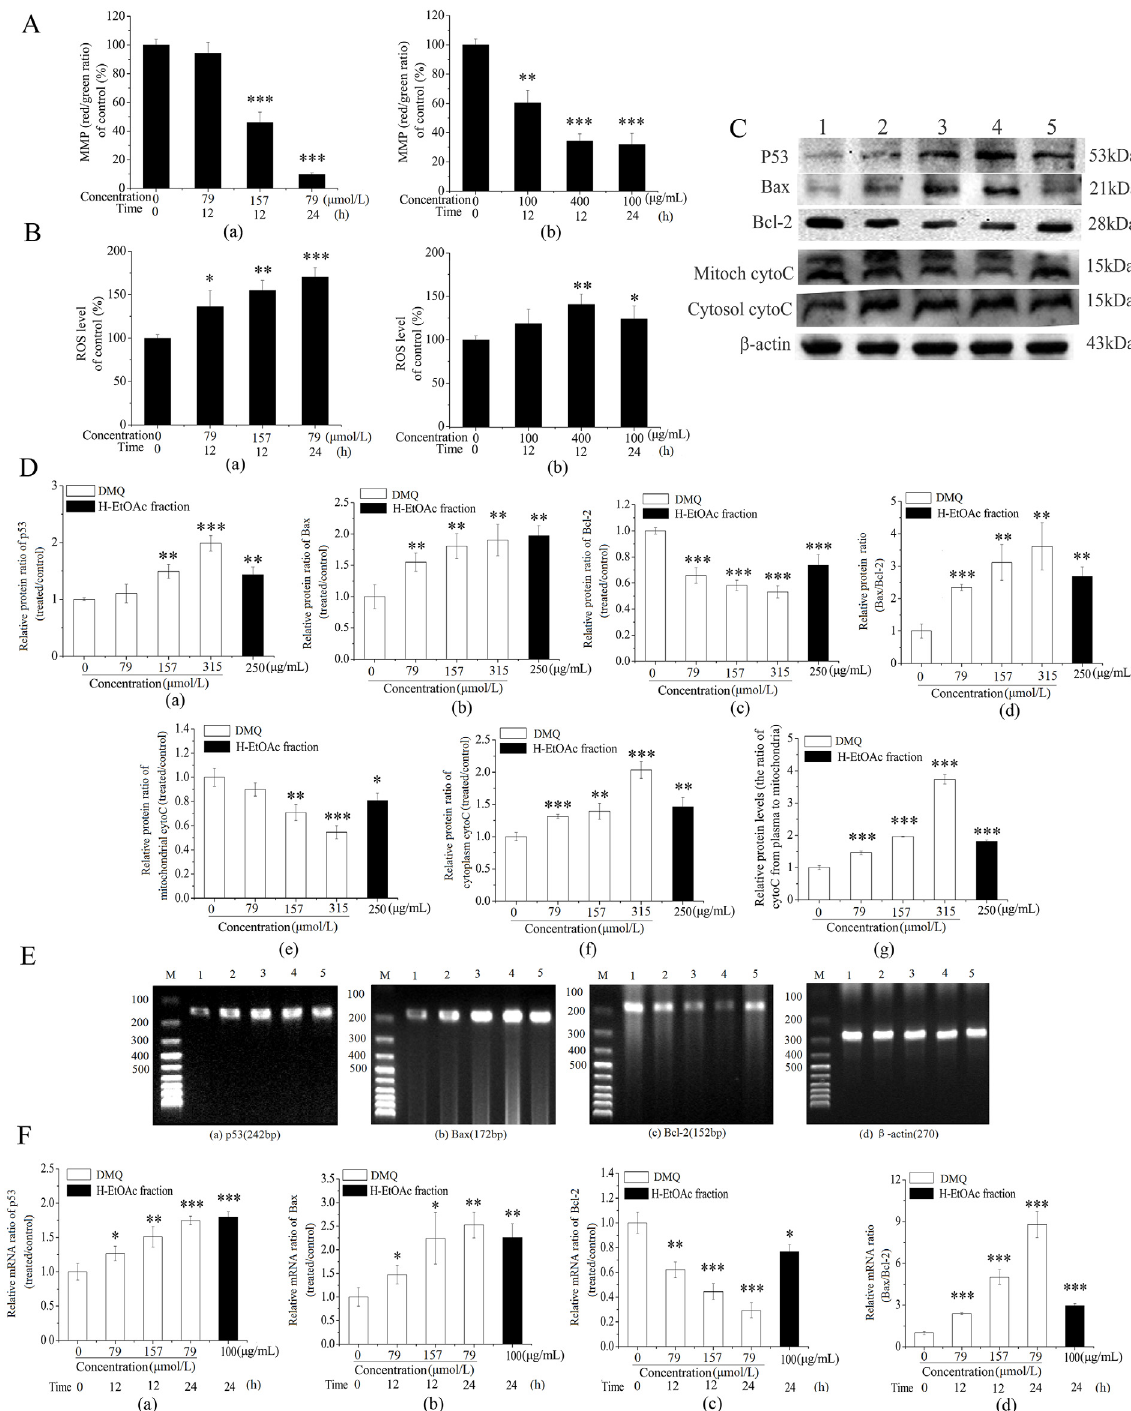
Fig 4. Mitochondrial Apoptotic Pathway Related to DMQ and H-EtOAc Fraction Treated HepG2 Cells. A. The MMP changes of HepG2 cells treated with DMQ (a) and H-EtOAc fraction (b). B. The production changes of intracellular ROS in HepG2 cells treated with DMQ (a) and H-EtOAc fraction (b). C. Western blot analysis of proteins expression levels of p53, Bax, Bcl-2, mitochondrial cyto C, cytoplasmic cyto C and β -actin. Lane 1: Control; Lane 2 – 4: 79, 157 and 315 μ mol/L of DMQ for 24 h, respectively; Lane 5: 250 μ g/mL of H-EtOAc fraction for 24 h. D. The protein expression levels of p53 (a) Bax (b) Bcl-2 (c) the ratio of Bax/Bcl-2 (d) mitochondrial cyto C (e) cytoplasmic cyto C (f) and the ratio of cytoplasmic cytoC/mitochondrial cyto C (g). The protein expression strength were analyzed by scanning densitometry using a Microtek ScanMaker 8700 (Zhongjing Inc. China) with ScanWizard 5 software. E. RT-PCR results